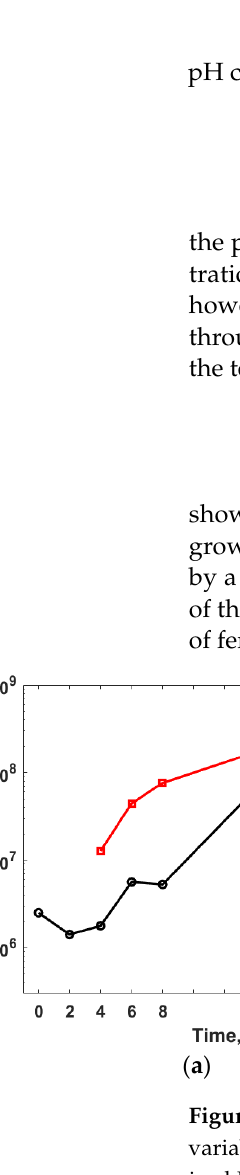
Figure 9. Genetic algorithm optimization by considering two regression terms and the response variable as a function of time, pH, and lactic acid concentration in case of uncontrolled pH: ( a ) com- parative trends and ( b ) normalized RMSE.